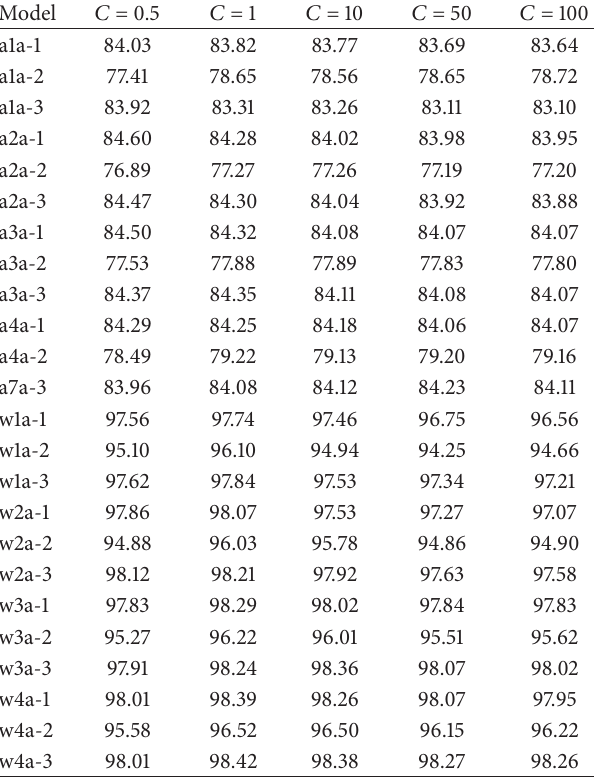
Table 3: Systematic recall for different parameter values (%).